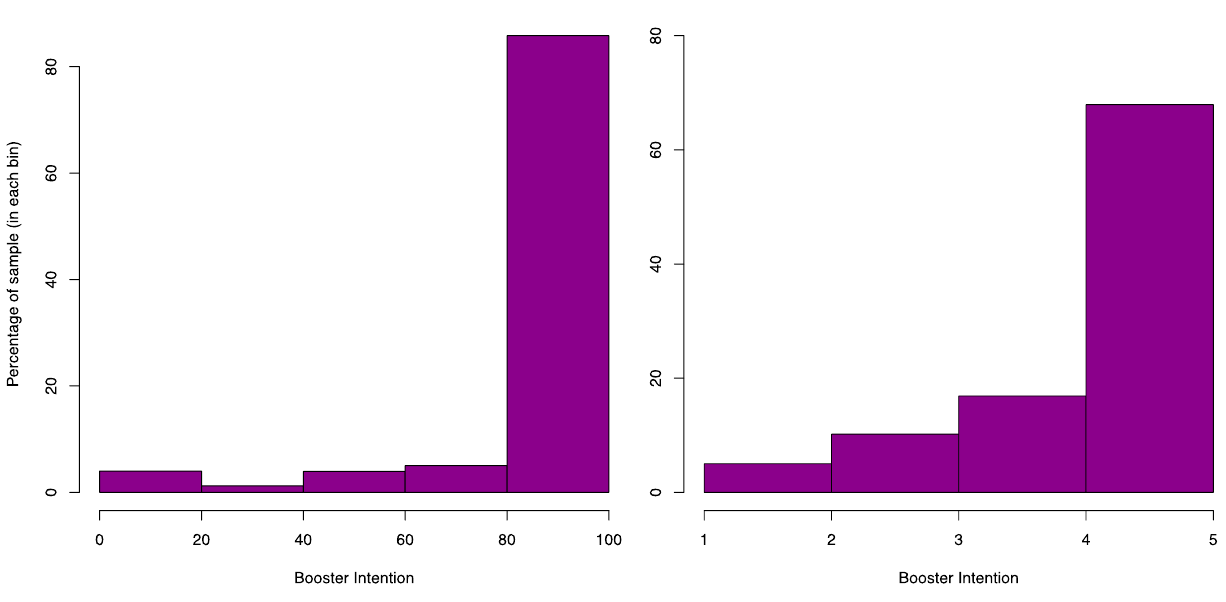
Figure 1. Distribution of the primary outcome (Booster Vaccine Intention) across the UK ( left ) and Australian ( right ) samples presented as the percentage of the sample in each bin of data.